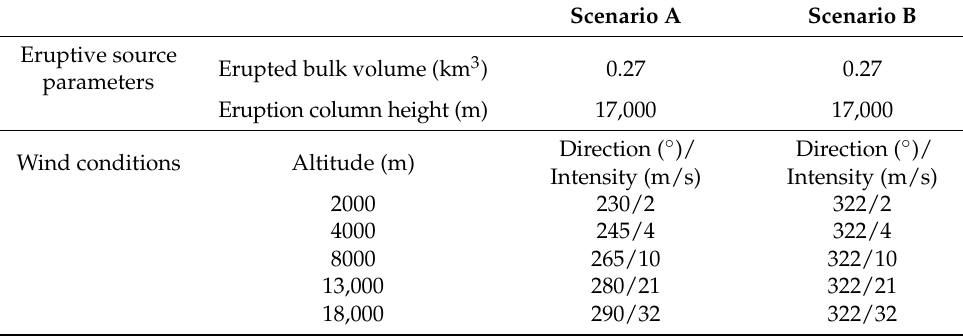
Table 1. Main input parameters for the two eruptive scenarios (adapted from [44]).